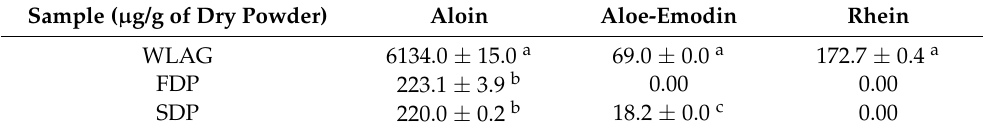
Table 1. Contents of aloin, aloe-emodin and rhein in whole-leaf Aloe vera gel (WLAG), freeze-dried powder (FDP) and spray-dried powder (SDP) of Aloe vera. (Values are mean and standard deviations from triplicate data. The data were analysed by one-way ANOVA and Tukey’s post hoc HSD tests. The different letters in superscript (a, b, c) within rows indicate statistically significant differences ( p < 0.05)). Sample ( µ g/g of Dry